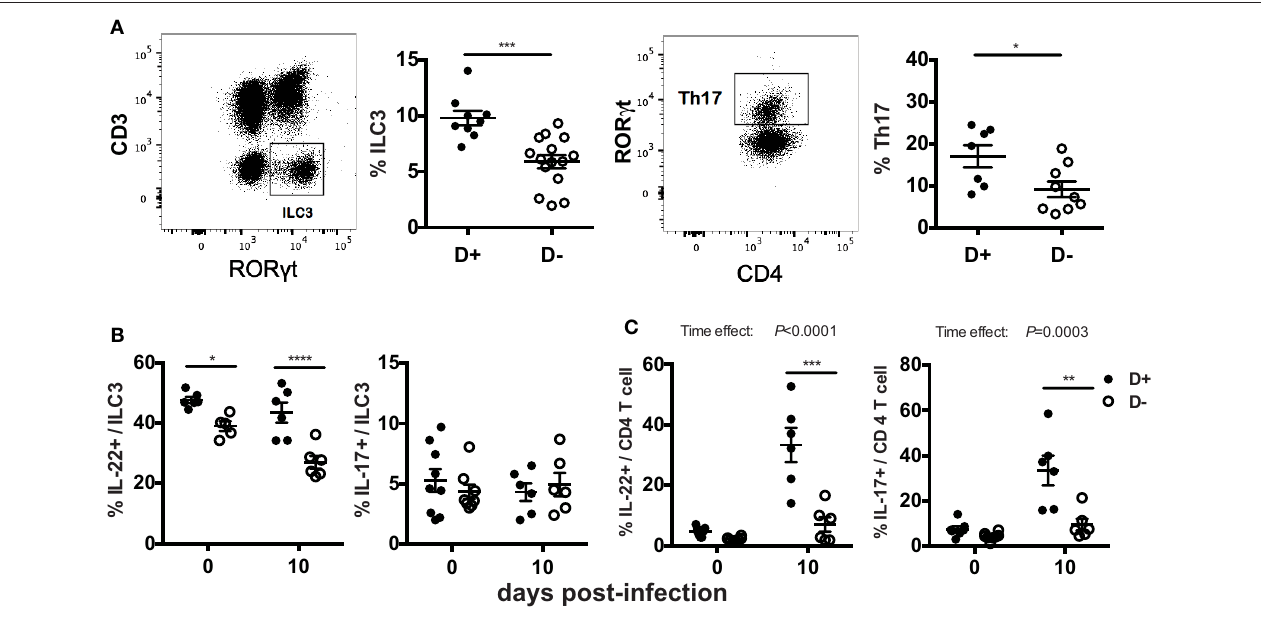
FIGURE 4 | Fewer ILC3 and Th17 cells in the colon of D- mice. Gating examples and frequencies of (A) ILC3 (Thy1 + ROR γ t + /CD3-) and Th17 (CD4+ROR γ t + /CD3 + ) in the colon of D + and D- mice. The frequencies of (B) ILC3 and (C) Th17 cells that secrete IL22 (left) or IL-17 (right). Values are mean ± SEM of two combined experiments and (A) ILC3, n = 9–15; Th17, n = 7–11, and (B) n = 6–9 mice per group. Significance was determined using two-tailed Student’s t tests (A) , two-way ANOVA with Bonferroni post-hoc tests (B,C) . * P < 0.05, ** P < 0.01, *** P < 0.001, **** P < 0.0001.